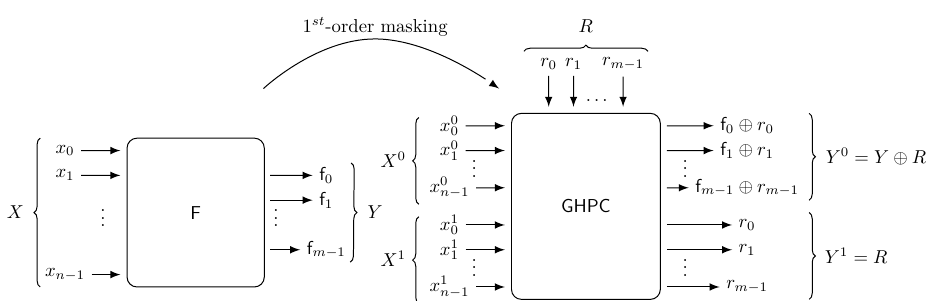
Figure 2: The GHPC concept of transforming any vectorial Boolean function into a first-order secure and composable gadget.